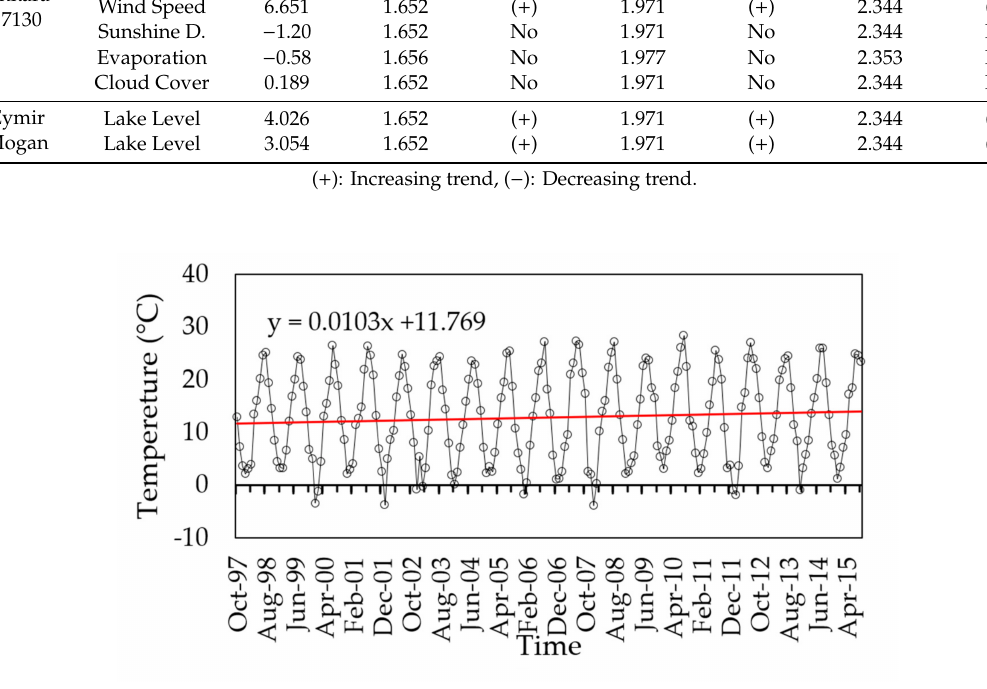
Water 2020 , 11 , x FOR PEER REVIEW Figure 3. Time series and linear trend analyses of temperature data between 1997 and 2015.